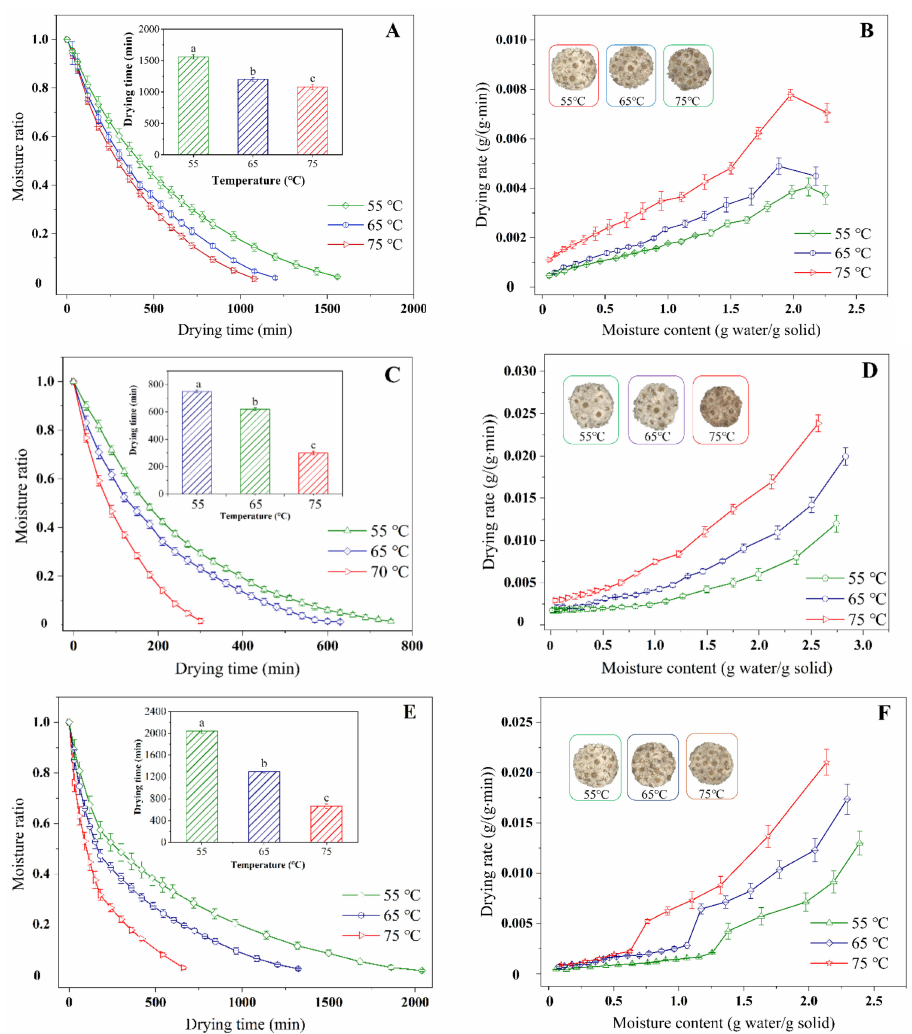
Figure 3. Moisture ratio ( A , C , E ) and drying rate ( B , D , F ) of chrysanthemum cakes under different drying methods: ( A , B ): hot air drying (HAD); ( C , D ): combined infrared and hot air drying (IR-HAD); ( E , F ): sequential IR-HAD and HAD (IR-HAD + HAD), different lowercase letters reveal significant differences ( p <